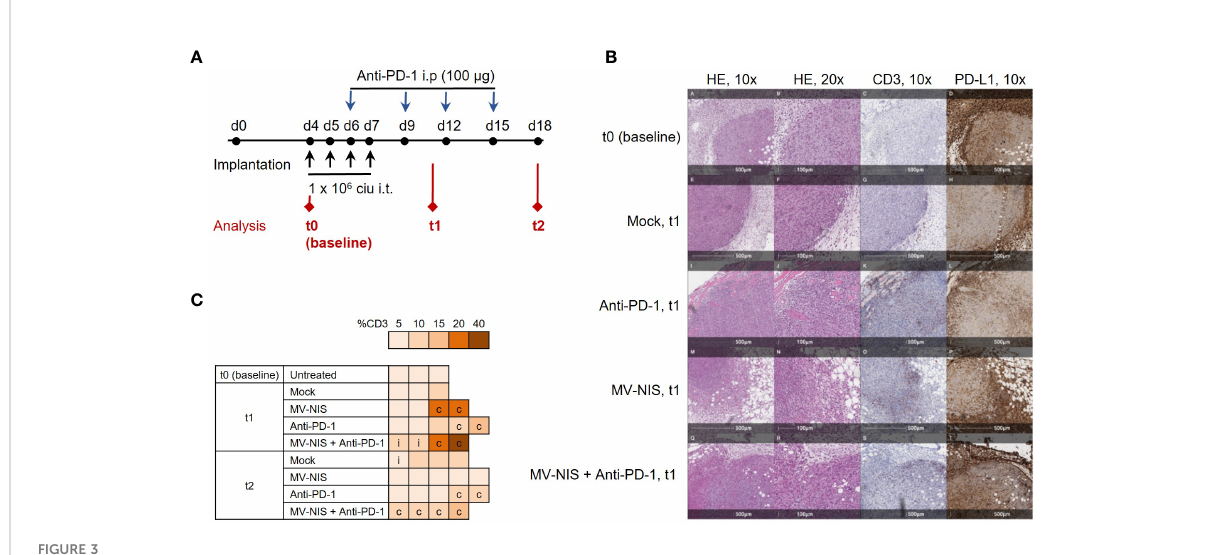
FIGURE 3 Tumor immune environment after MV-NIS and anti-PD-1 treatment. (A) Experimental outline. C57BL/6 mice bearing subcutaneous FC1245-CD46 tumors were treated as described above. Tumor samples for immuno-analyses were collected at depicted timepoints t0 (baseline), t1, and t2. (B) Histology and immunohistochemistry. Tumor sections collected at t0, t1, and t2 were stained with hematoxylin/eosin (HE) and with antibodies speci fi c for CD3 and PD-L1. Representative sections are shown. Scale bars correspond to 500 μm or 100 μm, respectively (as indicated). (C) CD3 expression. CD3 staining was used to determine the percentage of tumor stroma containing mononuclear immune cells according to (19). The percentage of CD3+ tissue is indicated by the color code; c indicates circumferential, i indicates intratumoral immune in fi